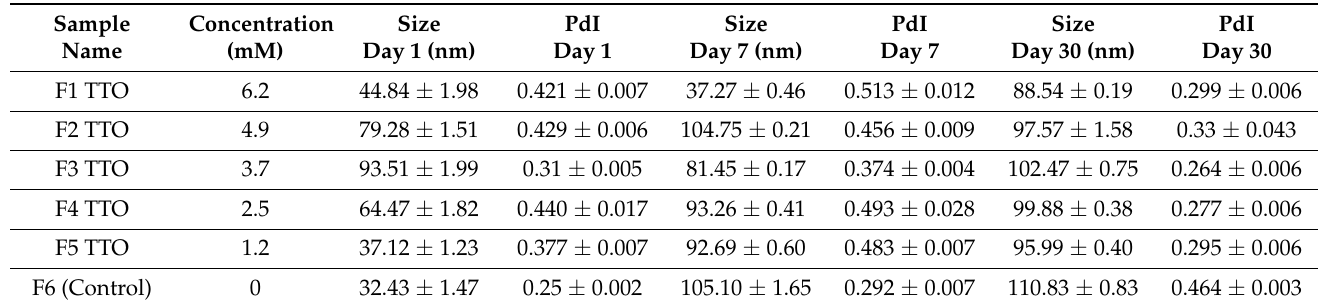
Table 2. The particle size distribution and PdI of TTO-loaded nanoliposomes (F1 to F5 fractions) and control sample (F6 fraction) rations after day 1, 7, and 30 of storage at 4 ◦ C . Data were articulated as mean values ± standard deviation.